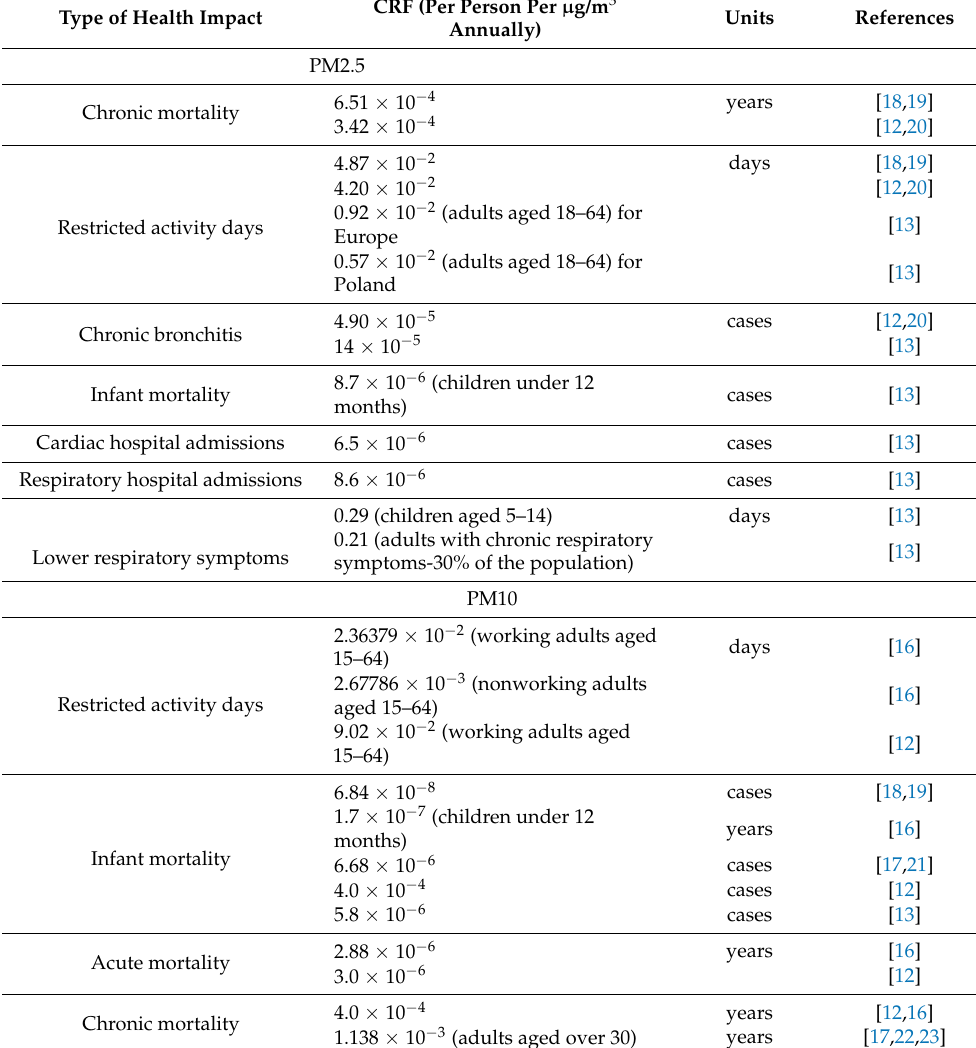
Table 1. The slopes of concentration–response functions (CRFs) associated with long-term exposure to pollutants. Based on